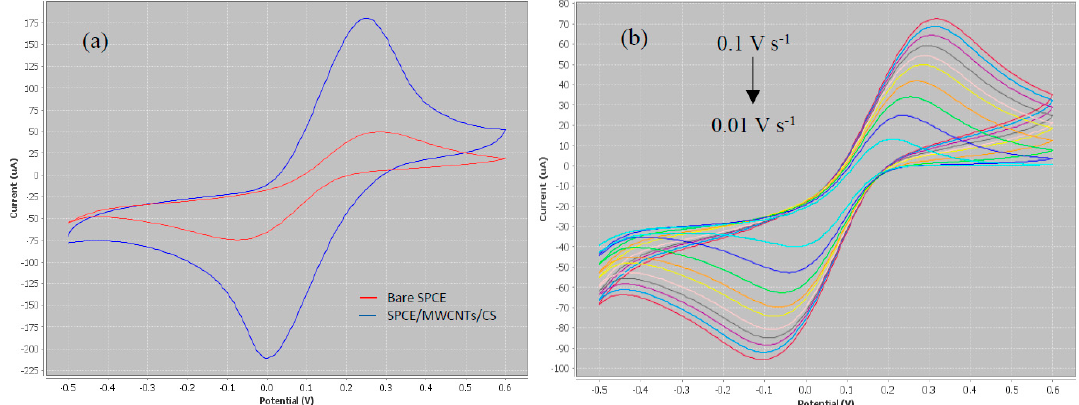
Figure 2. CV characteristics of: ( a ) screen-printed carbon electrode modified with MWCNTs and CS in comparison with bare electrode; and ( b ) modified electrode under different scan rate in a range of 0.01 to 0.1 V s − 1 . The analysis was done in 0.1 M PBS with 5 mM of K 3 [Fe(CN) 6 ]. Scan was set to three cycles from − 0.5 to 0.6 V (vs. Ag/AgCl).